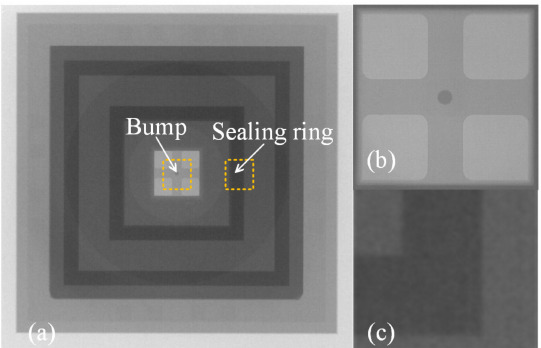
Figure 9. X-ray images. ( a ) Overall situation. ( b ) Round bump. ( c ) Sealing ring.